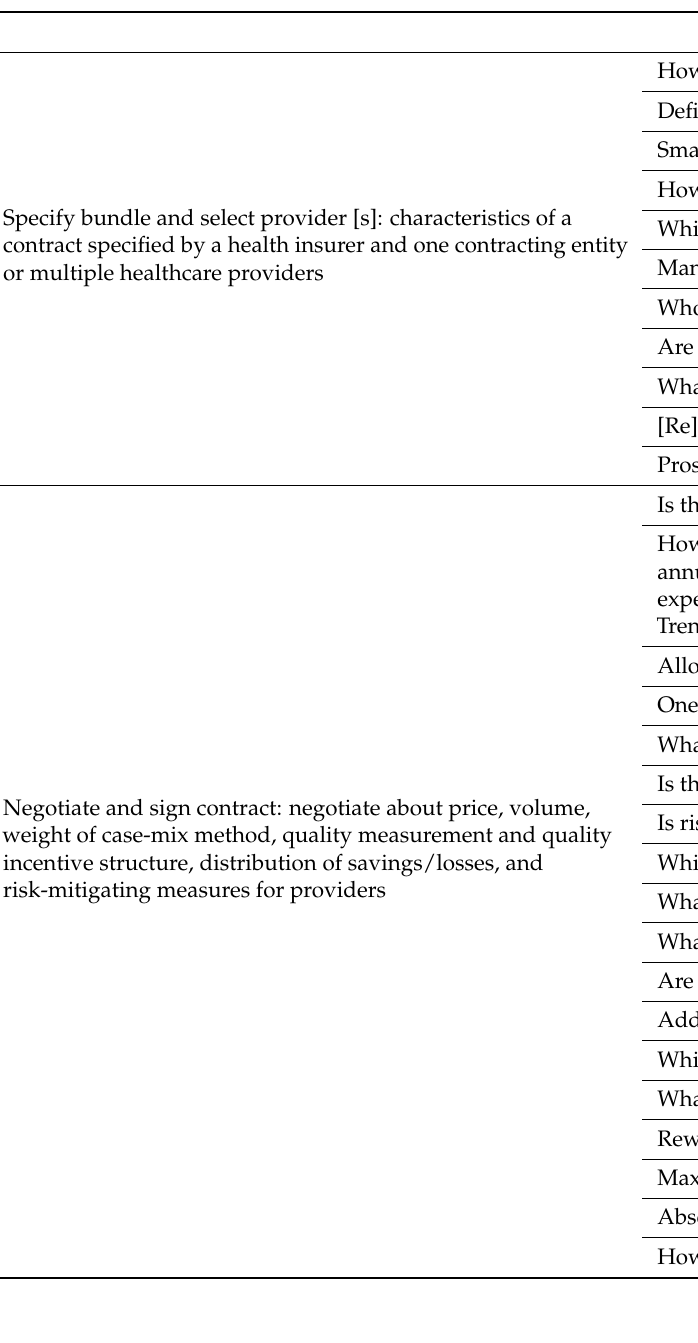
Table 1. Design elements for the implementation of an alternative payment model.